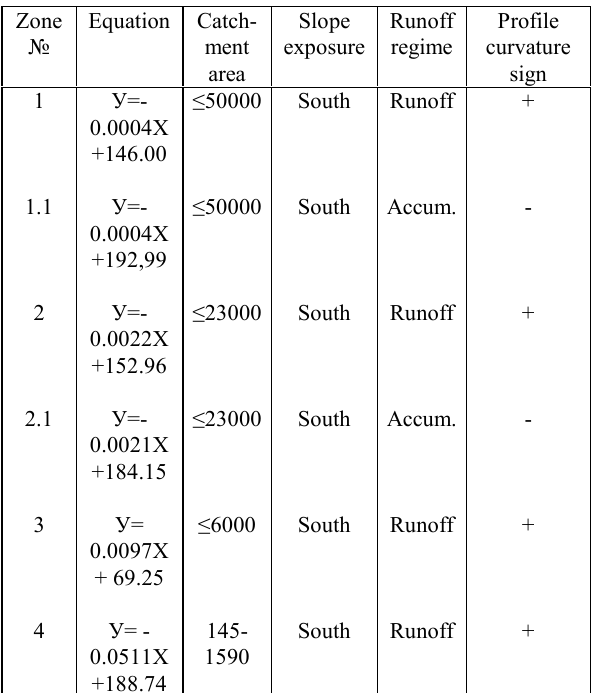
Table 1 . Equations for caesium-137 specific activity (Y) estimation using catchment area values (X) in zones 1-4.